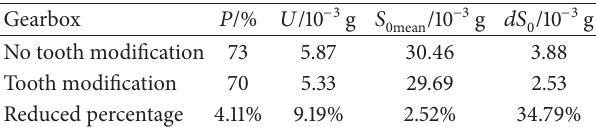
Table 3: Whole evaluation for gearbox vibration ( 𝑃 𝐵 = 100 %, 𝑖 = 4 , and 𝐵 = 3000